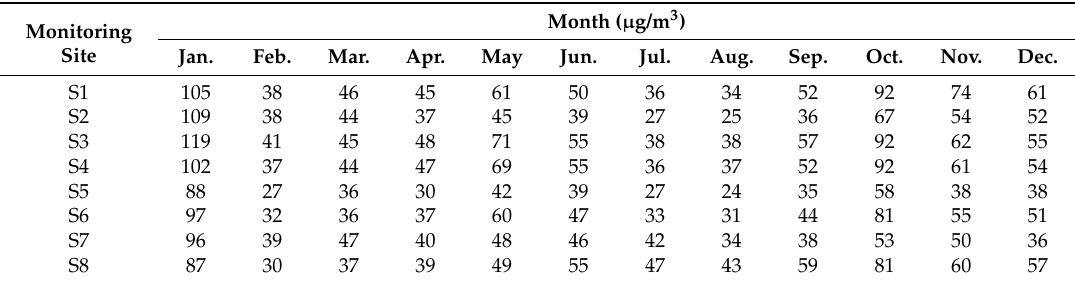
Table 1. The time-serial fine particulate matter (PM 2.5 ) concentrations for the eight monitoring sites in 2014.